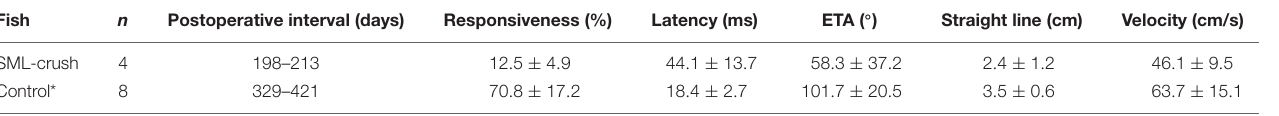
TABLE 2 | Comparison of startle response parameters between SML-crush and sham-operated control fish. Fish